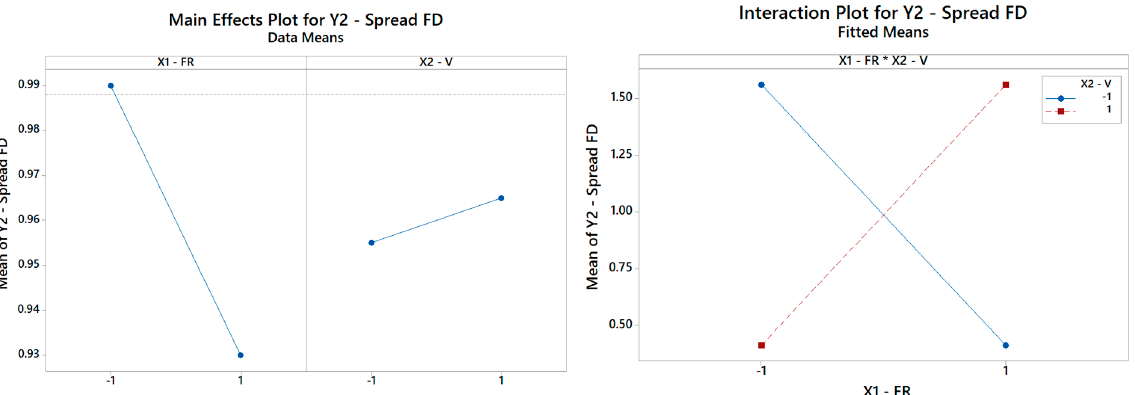
Figure 10. ( Left ) The main effects plot and ( right ) the interaction plot for the spread of FD (only the interaction term is significant and retained in the final model as per Table 7).